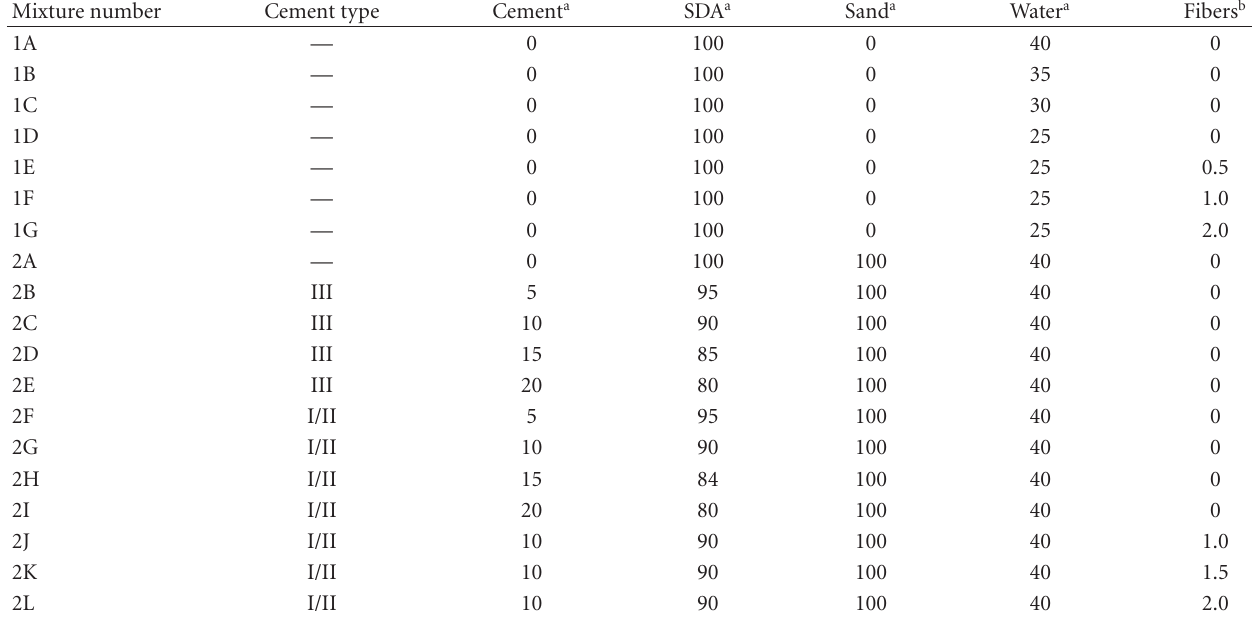
Table 2: Mixture